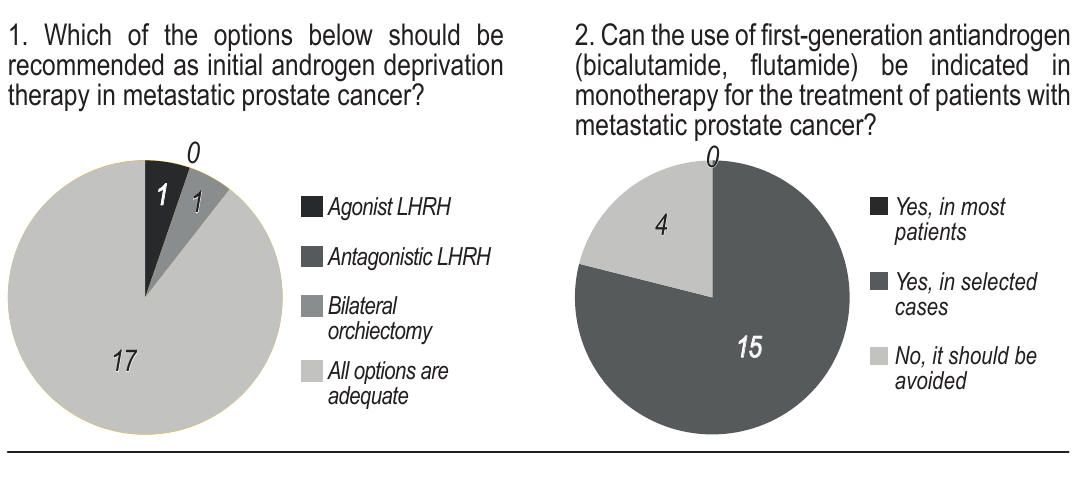
Figure 1 - Summary of all results of the voting process, with or without consensus. Figure 1. Votes regarding the section “Metastatic Prostate Cancer Sensitive to